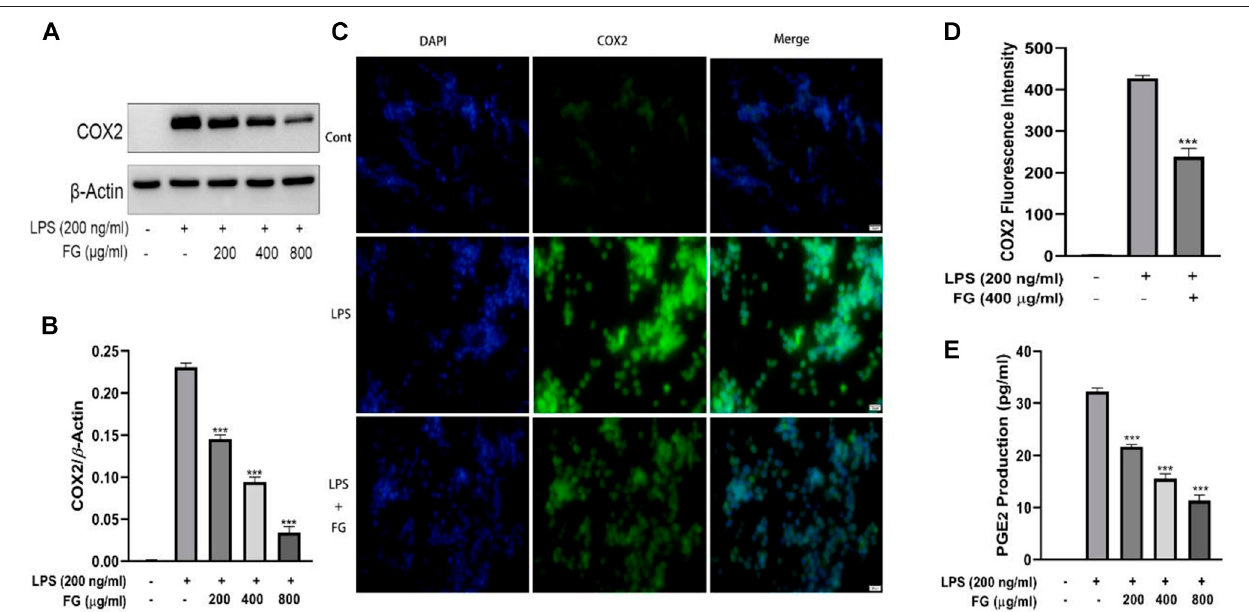
FIGURE6| EffectsofFGonCOX2andPGE 2 productioninLPS-inducedBV2microglia.BV2cellsweretreatedwithFGextraction(200,400,and800 μ g/ml)inthe presenceofLPS(200 ng/ml) for24 h. Expressionand localizationofCOX2weredetected byWestern blotand immuno fl uorescence (A – D) .PGE 2 level inthecellculture supernatant was detected using an ELISA kit (E) . Results are expressed as mean ± SEM of three independent experiments ( *** p < 0.001).